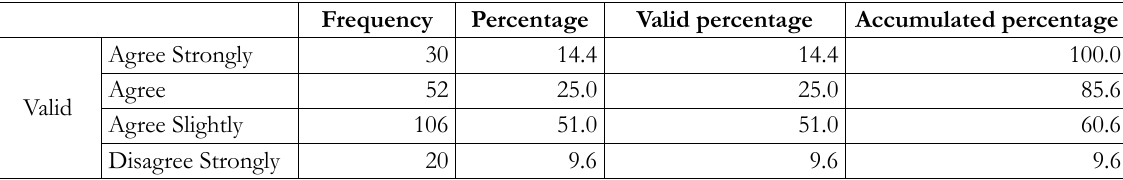
Table 6. Item “Are ICT being used in the